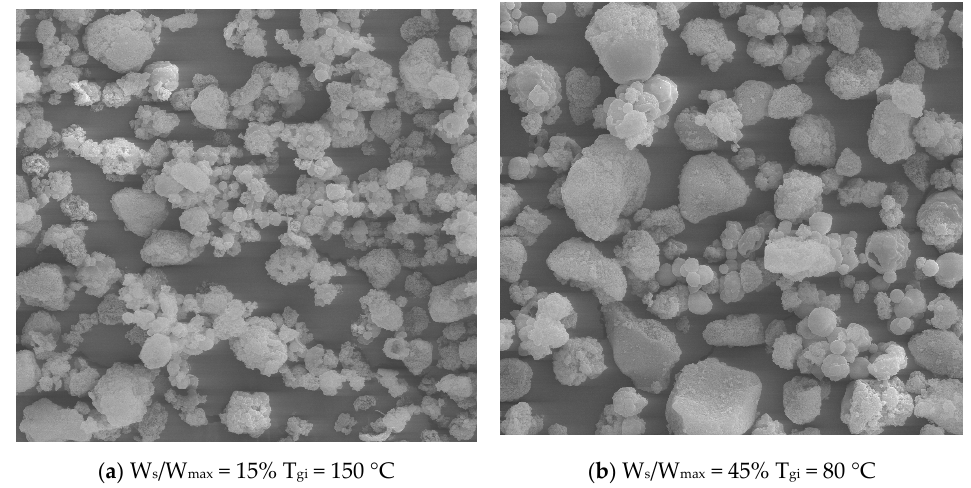
Figure 3. Typical SEM photomicrographs (magnification of 1000×) of spouted bed dried rosemary extracts produced at distinct operating conditions: ( a ) at W s /W max (15%) and T gi (150 °C), ( b ) at W s /W max (45%) and T gi (80 °C) (see Table 2).